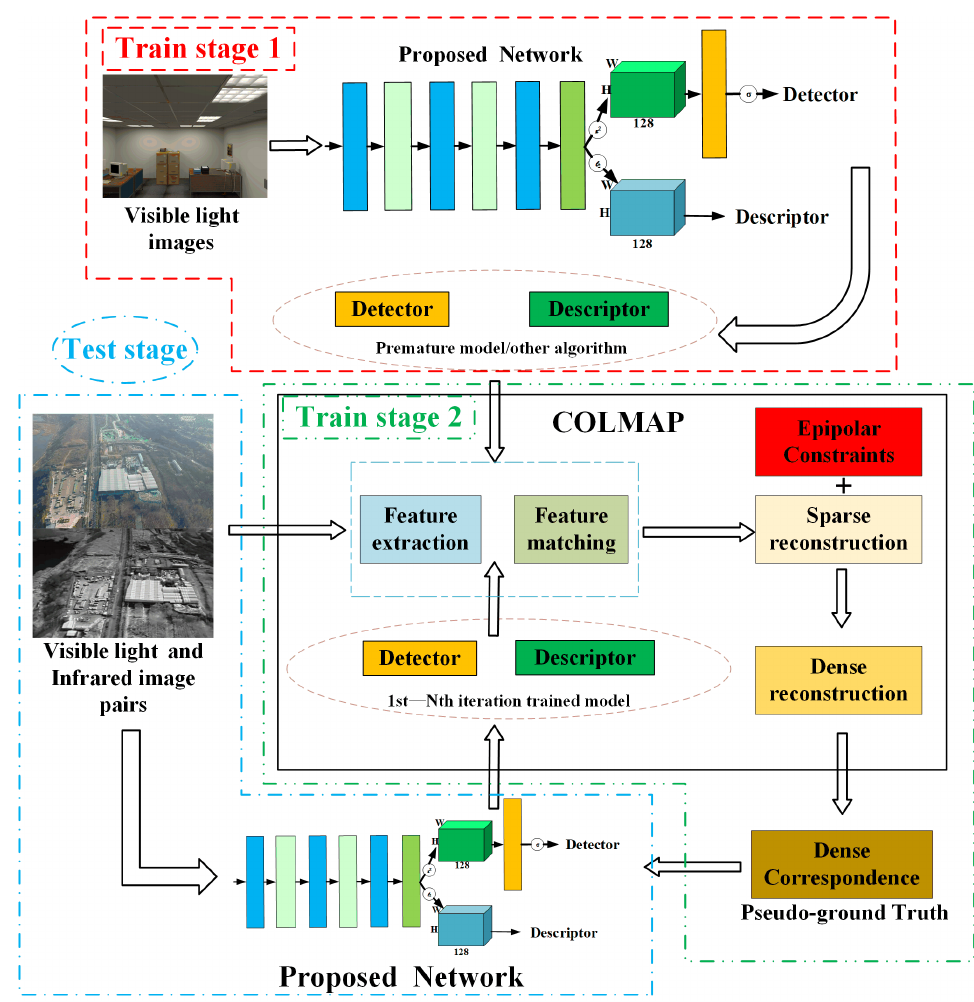
Figure 3. Overview of the proposed